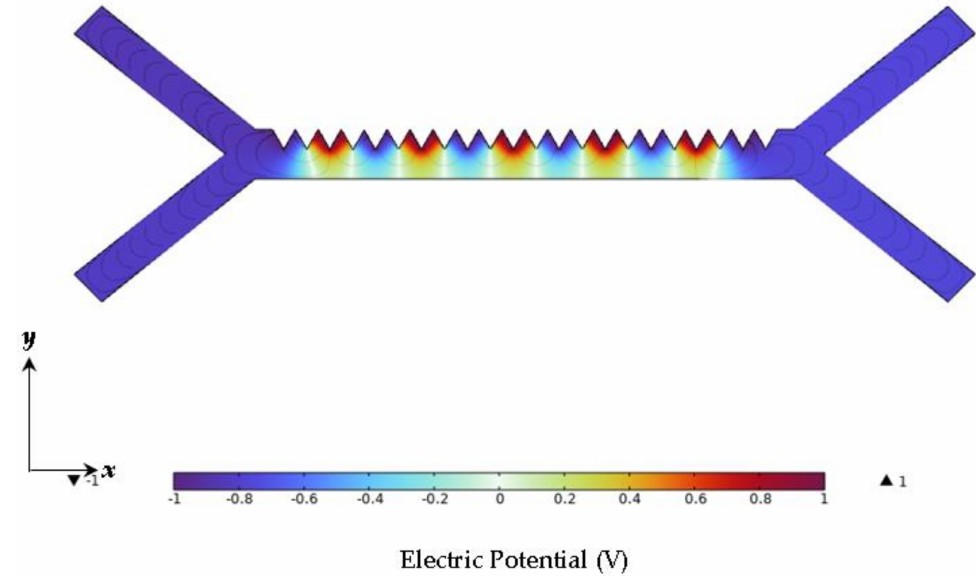
Figure 14. Contour of electric field potential and